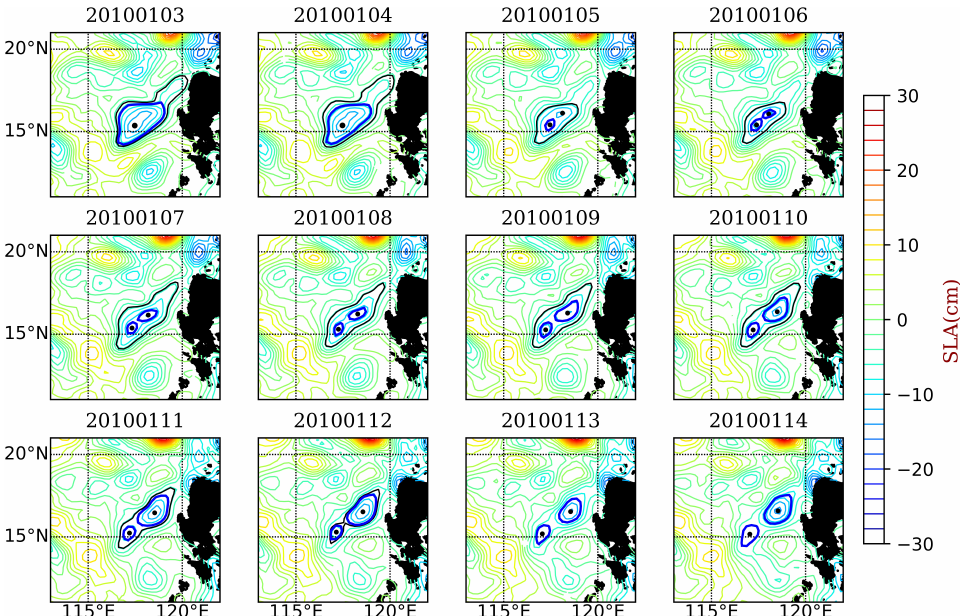
Figure 10. A splitting event of a cyclonic eddy detected by our algorithm. Mononuclear ed- dies/multicore eddies and eddygroups are blue lines and black lines, respectively, while the eddy cores of mononuclear eddies/multicore eddies and eddy seeds are black dots.